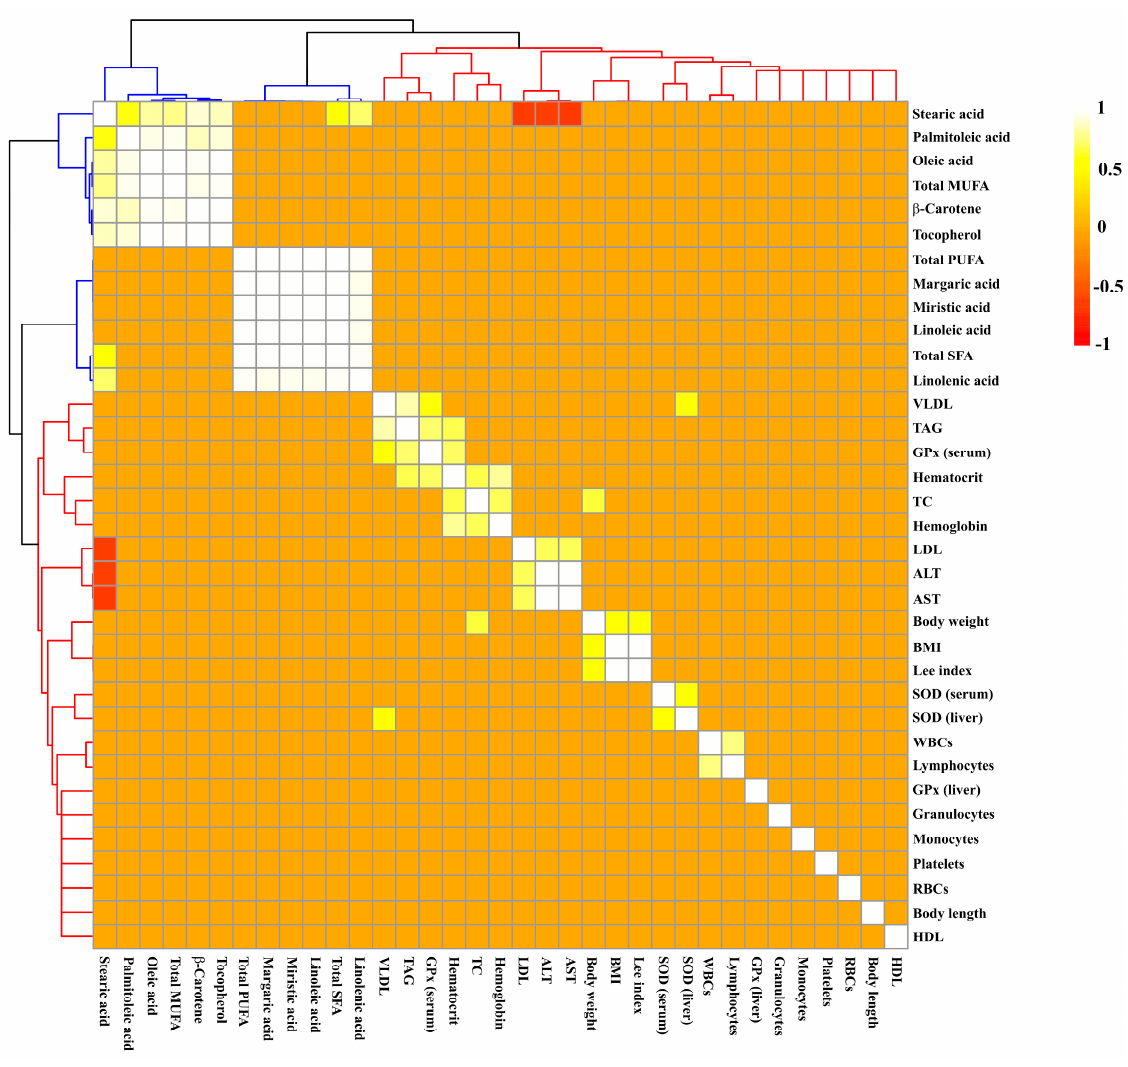
Figure 3. Hierarchical grouping based on Pearson’s correlation matrix between chemical compounds of oils and biological parameters of rats treated or not with a high dose of FeSO 4 and diets added with either soybean oil or buriti oil. Significant correlations were determined based on r ≥ 0.6 and p ≤ 0.05. Positive and negative correlations are shown as yellow-white and red, respectively. Clustering of the correlation matrix reveals two clusters represented by colors: blue (compounds of oils) and red (biological parameters). ALT = alanine aminotransferase; AST = aspartate aminotransferase; BMI = body mass index; DPPH = 1,1-diphenyl-2-picrylhydrazyl; GPx = glutathione peroxidase; HDL = high-density lipoprotein; LDL = low-density lipoprotein; MUFA = monounsaturated fatty acids; PUFA = polyunsaturated fatty acids; RBCs = red blood cells; SFA = saturated fatty acids; SOD = superoxide dismutase; TAG = triacylglycerides; TC = total cholesterol; VLDL = very low density lipoprotein; WBCs = white blood cells.